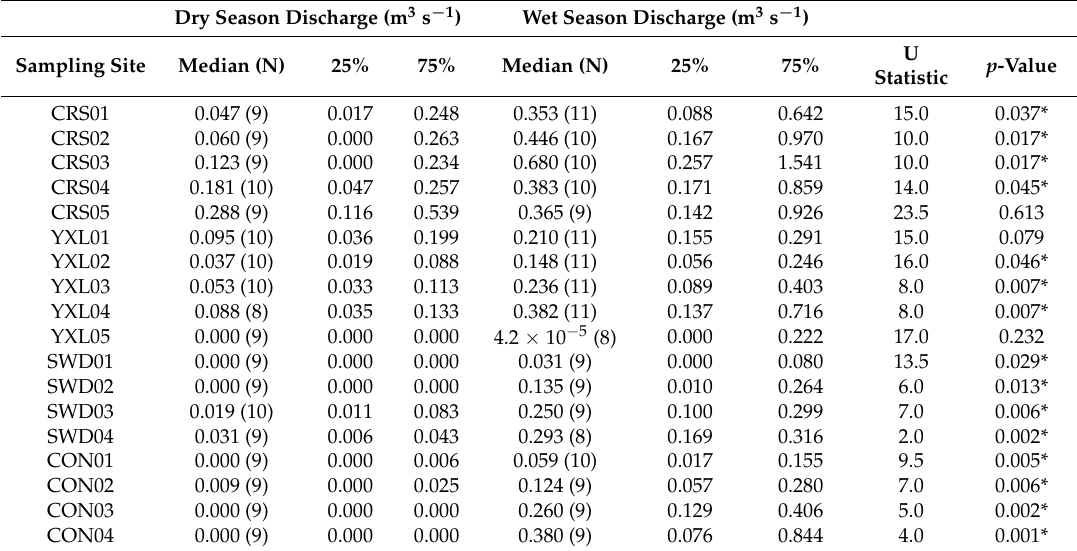
Table 2. Comparison of dry and wet season discharge rates (m 3 s − 1 ) across all sampling sites. (Mann–Whitney U statistic, p -value ≤ 0.05). * denotes significant difference ( p -value ≤ 0.05).